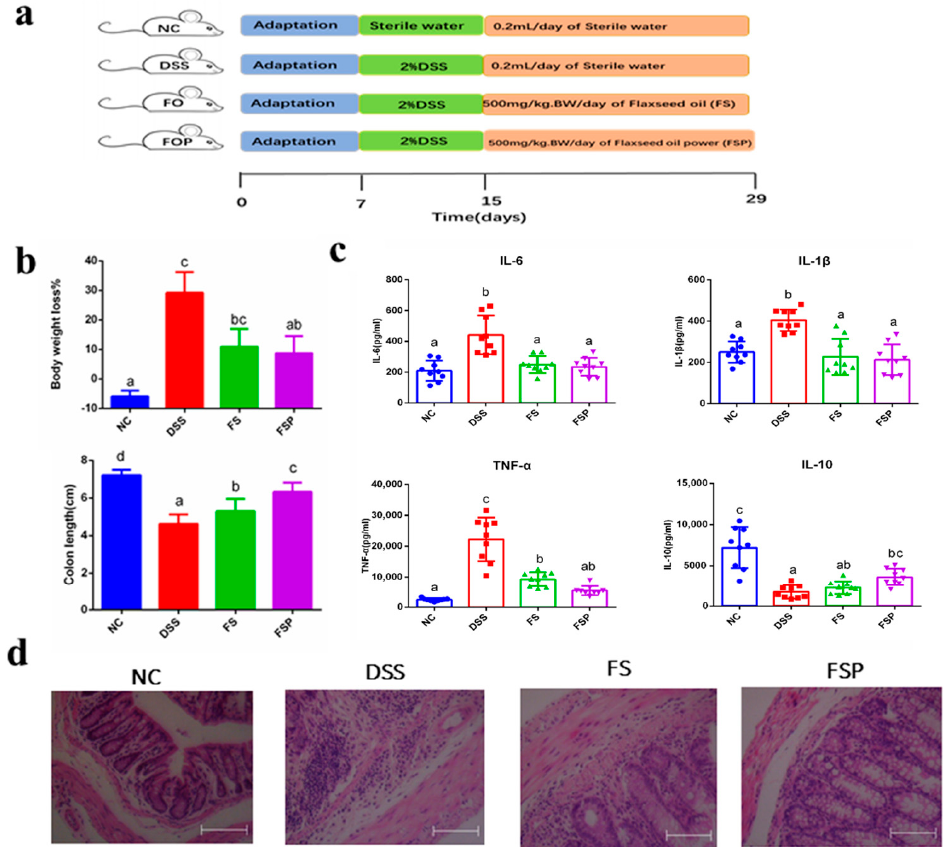
Figure 5. The schematic representation of the experiment ( a ), mice body weight change and colon length ( b ), inflammatory cytokine (IL-6, IL-1 β , TNF- α and IL-10) levels in colonic tissue ( c ) and histopathological changes and assessment of colonic tissues from the experiment group ( d ). Groups are labeled from smallest to largest in the order of mean value. Mean values with different letters are significantly different ( p < 0.05).